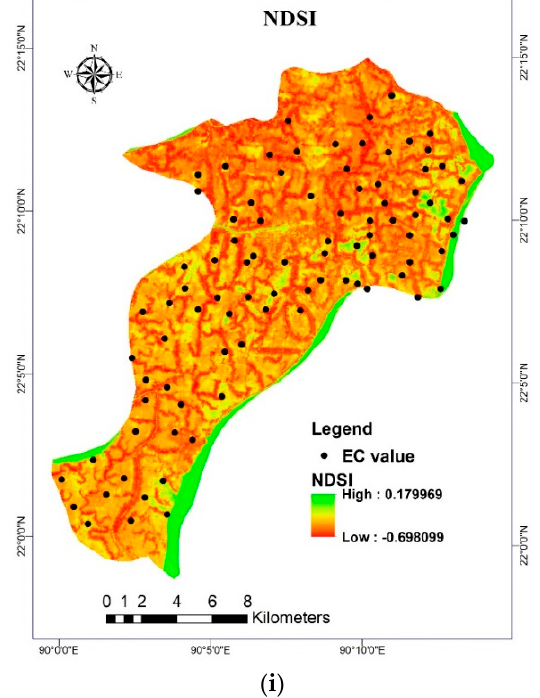
Figure 6 . ( a ) Salinity map using salinity index 1; ( b ) Salinity map using salinity index 2; ( c ) Salinity map using salinity index 3; ( d ) Salinity map using salinity index 4; ( e ) Salinity map using salinity index 5; ( f ) Salinity map using salinity 6; ( g ) Salinity map using salinity index 7; ( h ) Salinity map using salinity index 8; ( i ) Salinity map using NDSI.